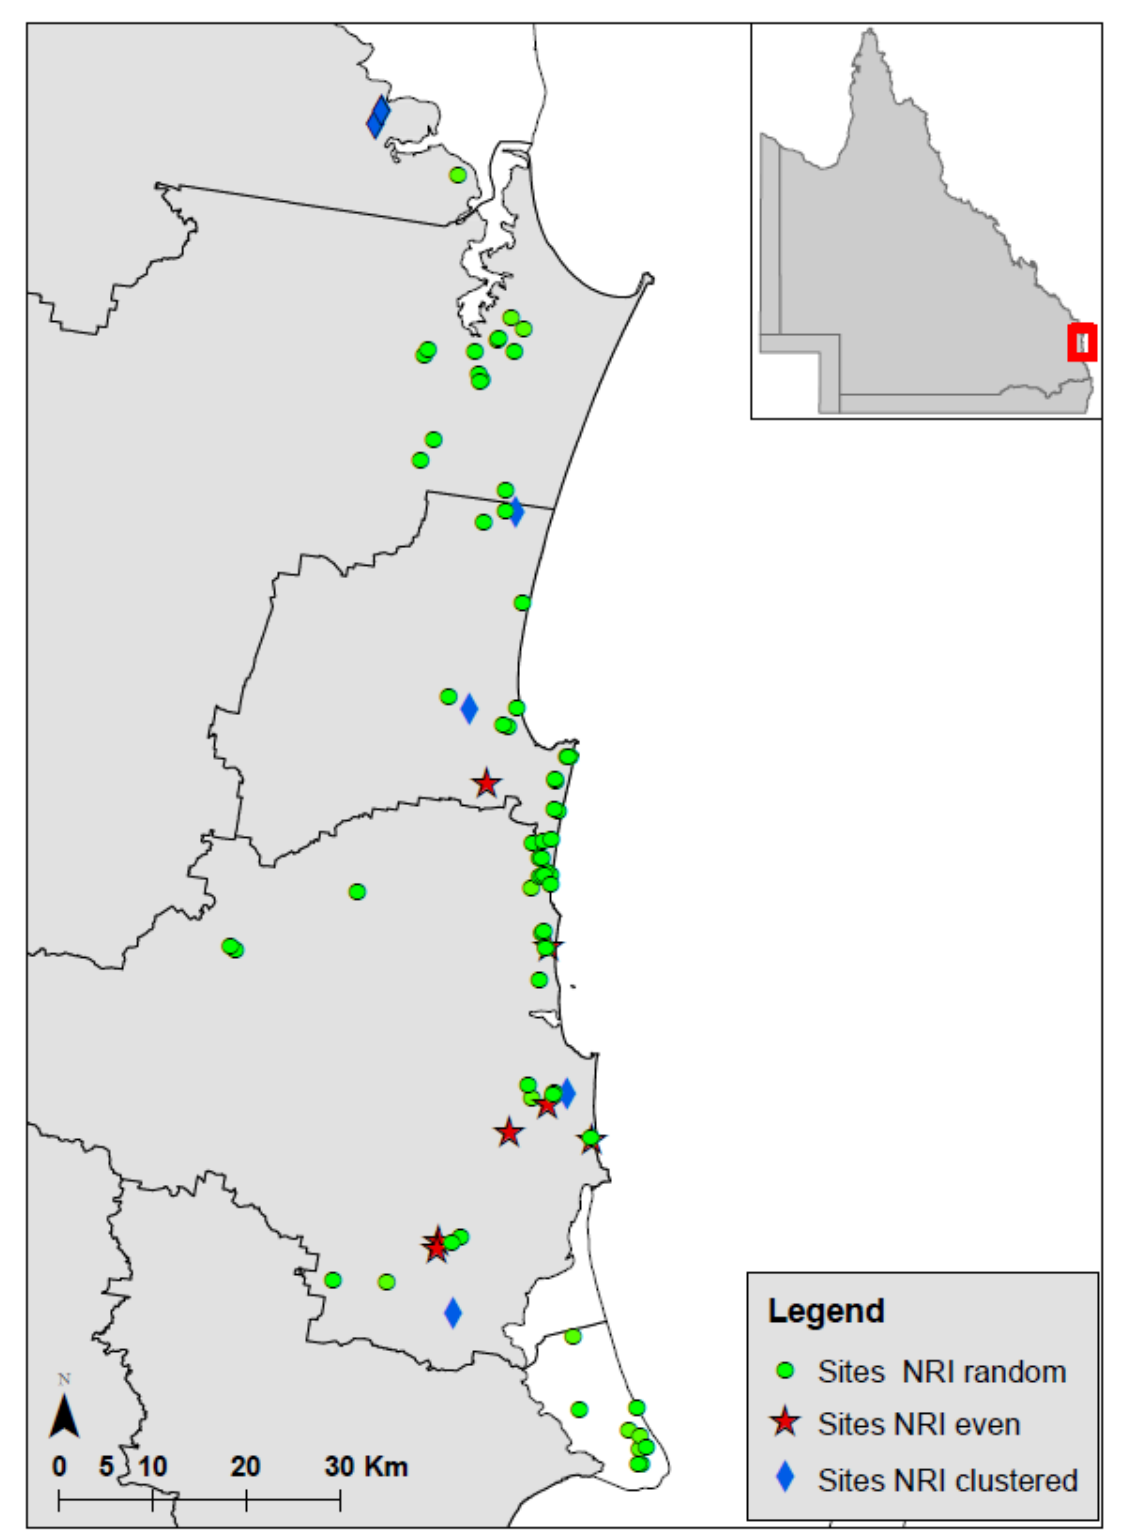
Figure 1. Map of Queensland [66], Australia indicating the Sunshine Coast study area. In the expanded box, the Sunshine Coast area showing the location of the 80 sites. Sites are marked by their NRI results: phylogenetically clustered, random, or even.